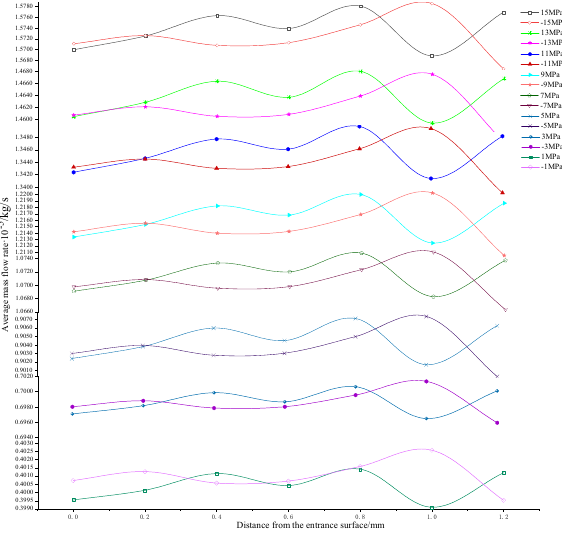
Figure 24. The mass flow rate curve of each section under different pressure drops.